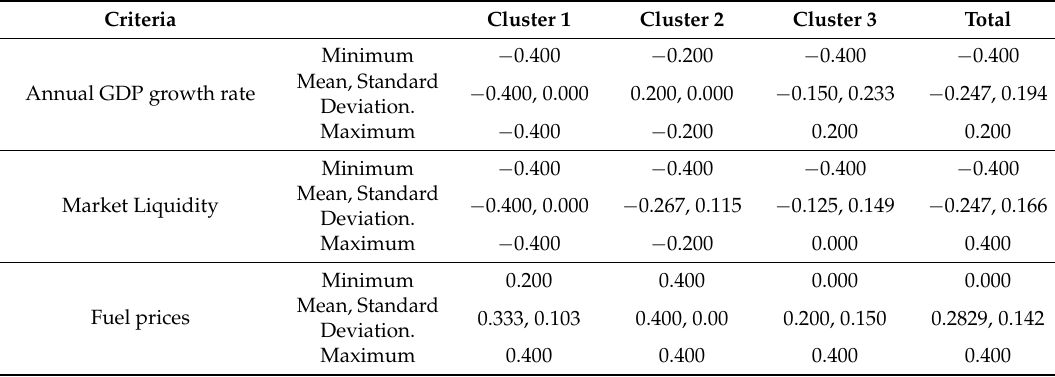
Table A1. Descriptive statistics according to group